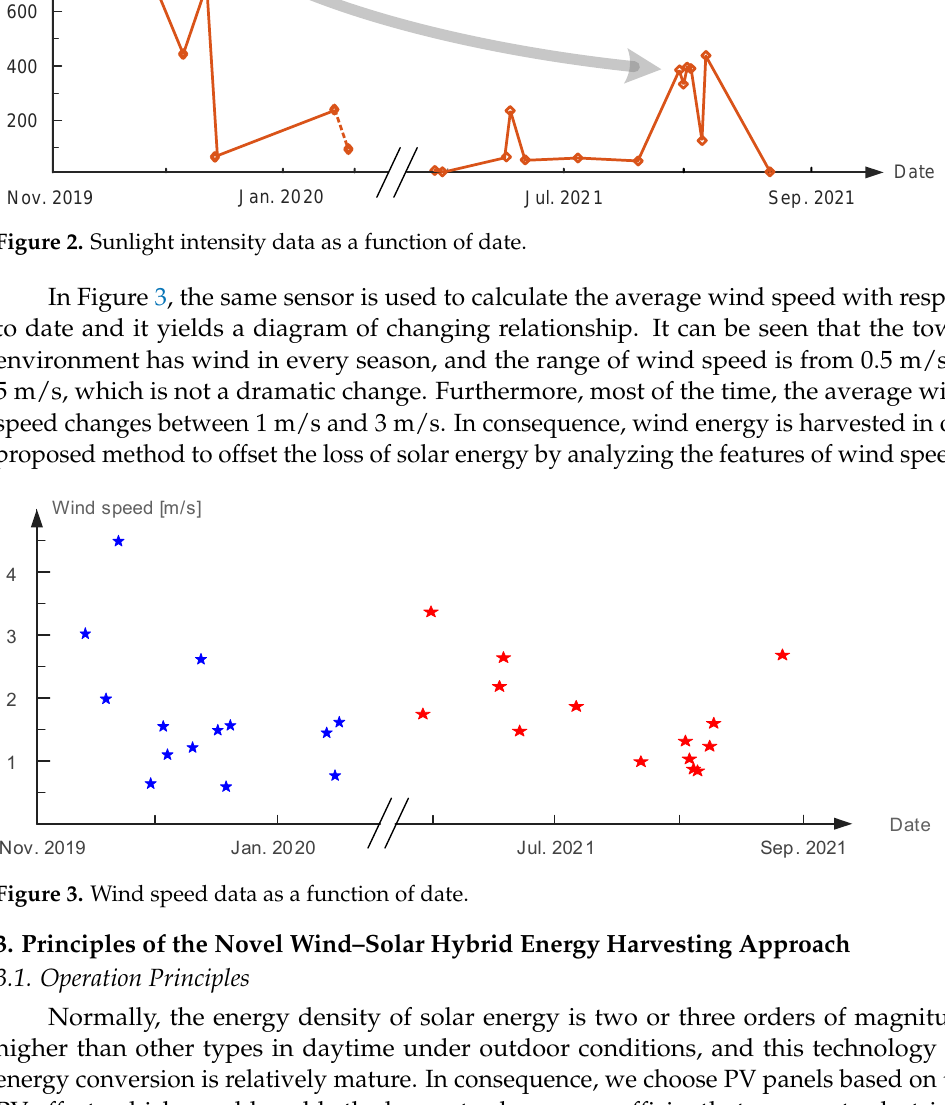
Figure 3. Wind speed data as a function of date.